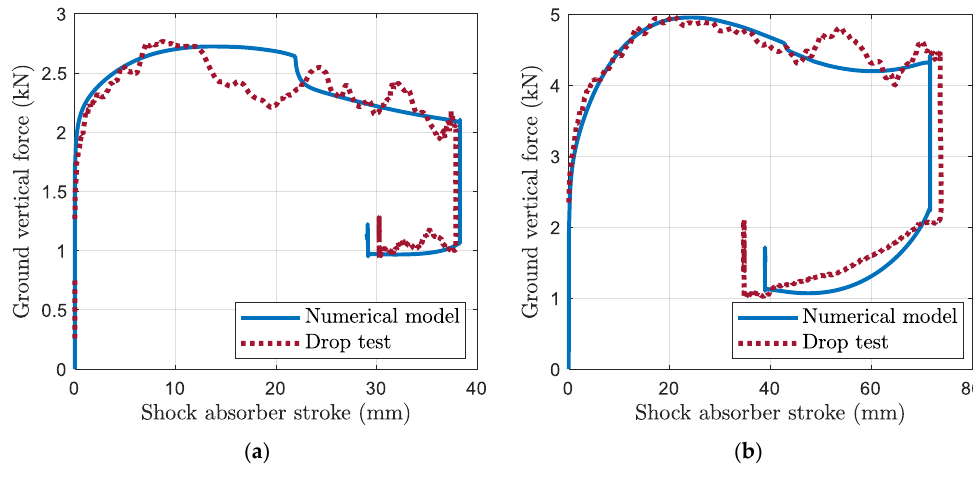
Figure 7. The ground vertical force curve with shock absorber stroke: ( a ) LC-1; ( b ) LC-2.